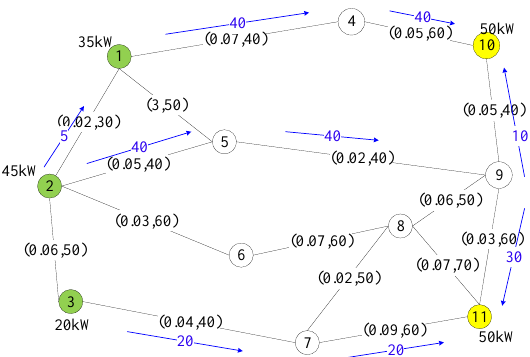
Figure 3. Paths selected by the optimal method on a simple network.